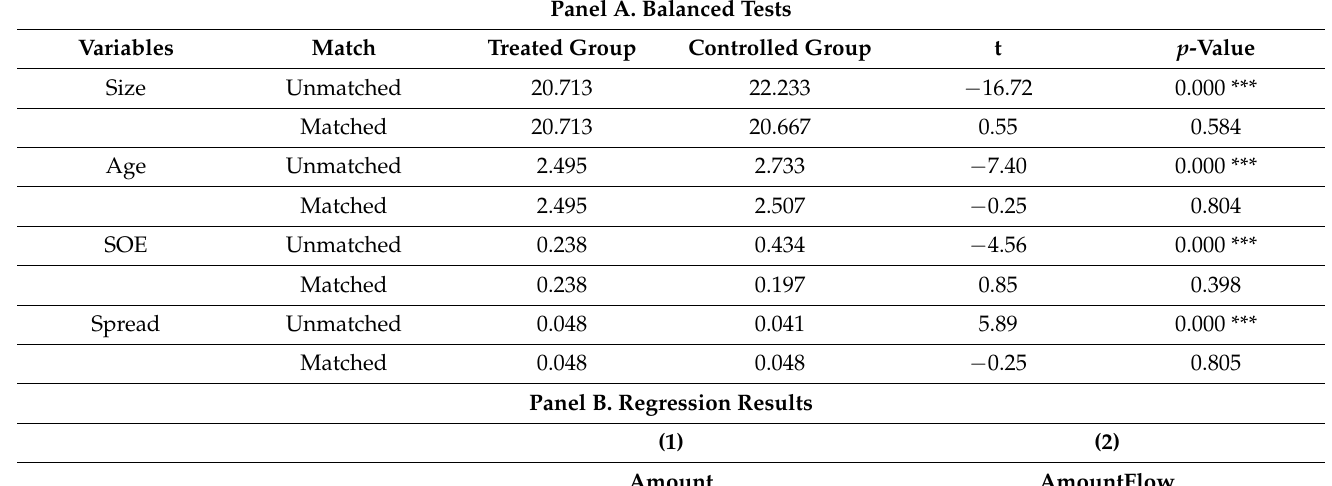
Table 5. Results of propensity score matching difference in difference (PSM-DID) model. Panel A. Balanced Tests